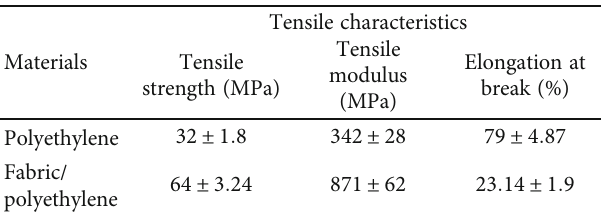
Table 1: Tensile characteristics of polyethylene (PE) and fabric/PE composites.